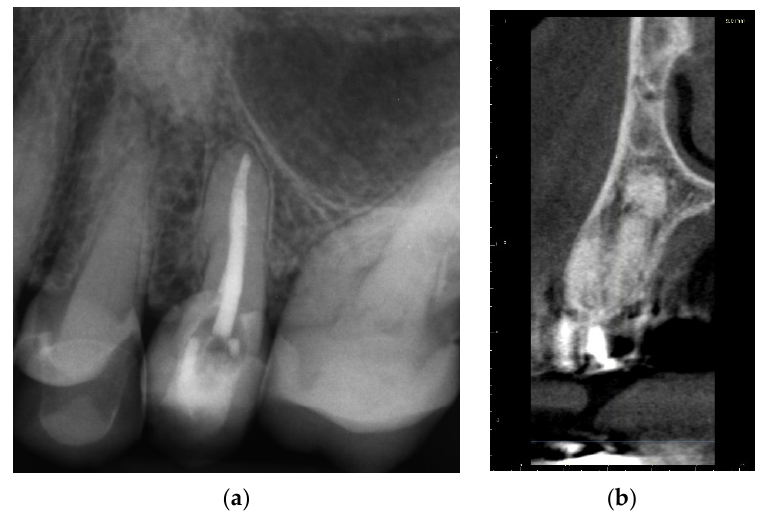
Figure 19. Nonvisible root canal system on ( a ) X-ray and ( b ) CBCT images (tooth 24). Three-Dimensional Treatment Plan and RCT